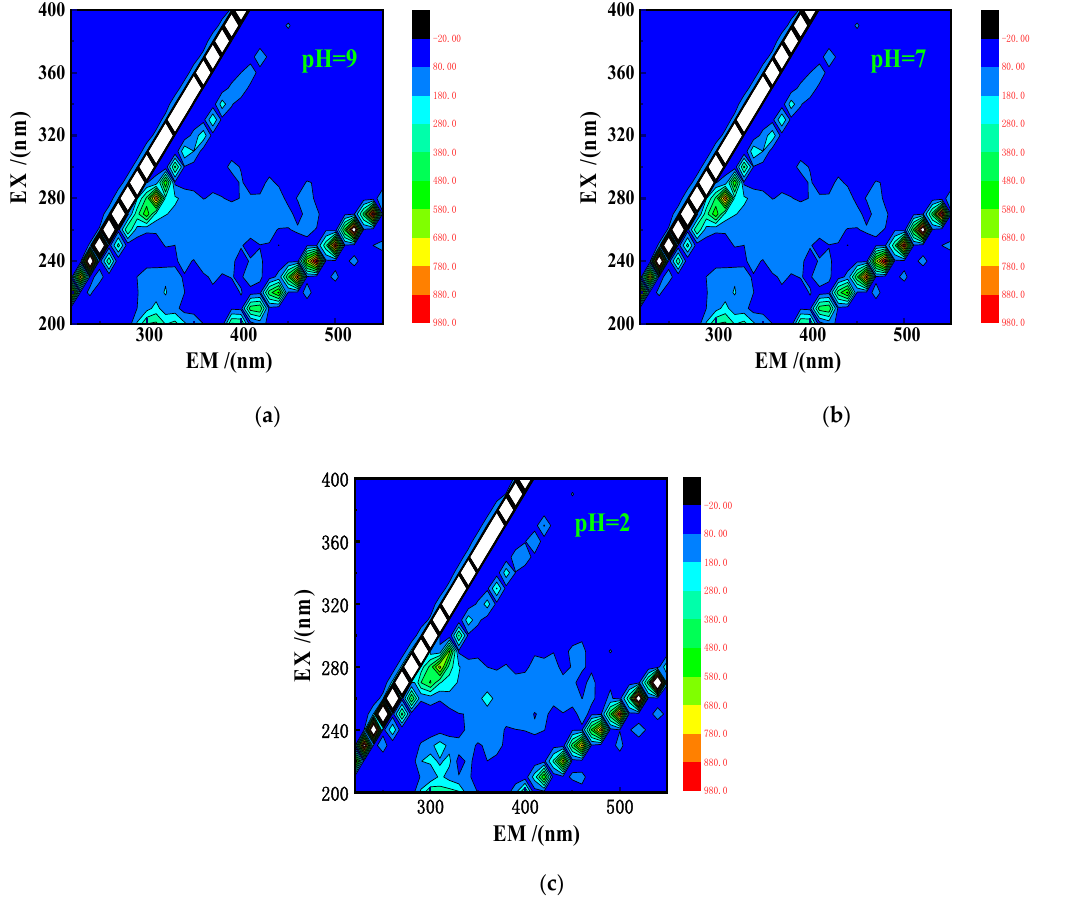
Figure 5. EEMs maps of PACMC’s supernatant at different pH conditions ( a ) pH = 9. ( b ) pH = 7. ( c ) pH = 2.